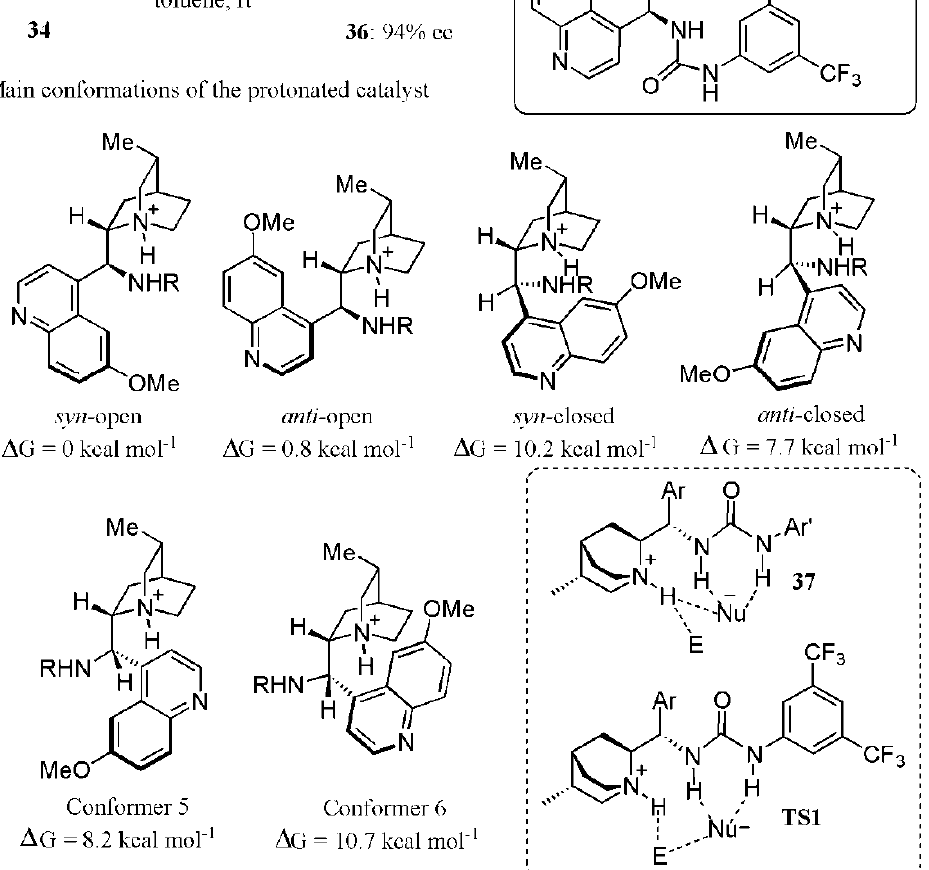
Figure 26. Asymmetric conjugate addition of thiophenol to cyclopentenone catalyzed by cinchona alkaloid-urea C20 [61] and possible conformations of the protonated catalyst C21 [48]. All energies are in kcal mol − 1 .